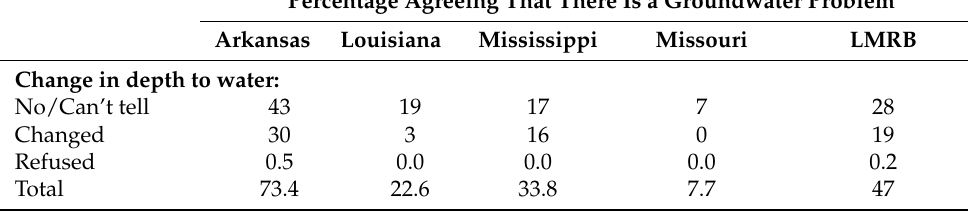
Table 11. Difference in farmer perceptions and attitudes regarding changes in aquifer levels and presence of groundwater problems across the